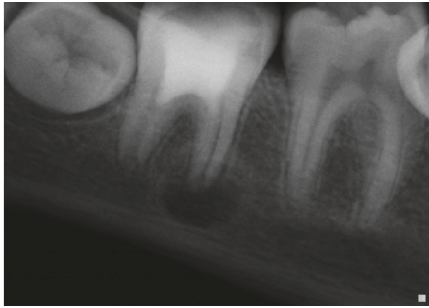
Figure 5: Radiograph after 10 months’ recall: enlargement of the radiolucent image at the mesial roots.